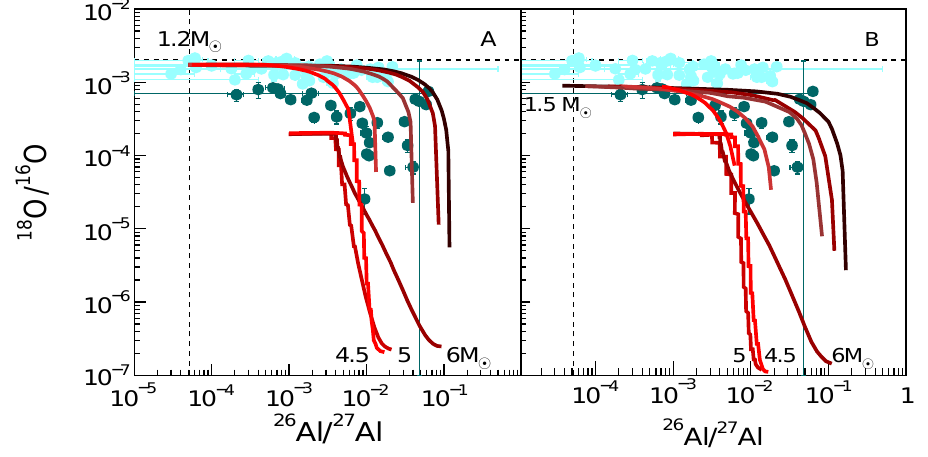
Figure 5. The 18 O/ 16 O isotopic ratio as a function of the 26 Al/ 27 Al one for the same models and grain data as in Figure 3. Horizontal and vertical dashed lines represent the solar values for the 18 O/ 16 O and the 26 Al/ 27 Al isotopic ratios. Panel ( A ) refers to calculations run with reaction rates of set A and Panel ( B ) to calculations run with the set